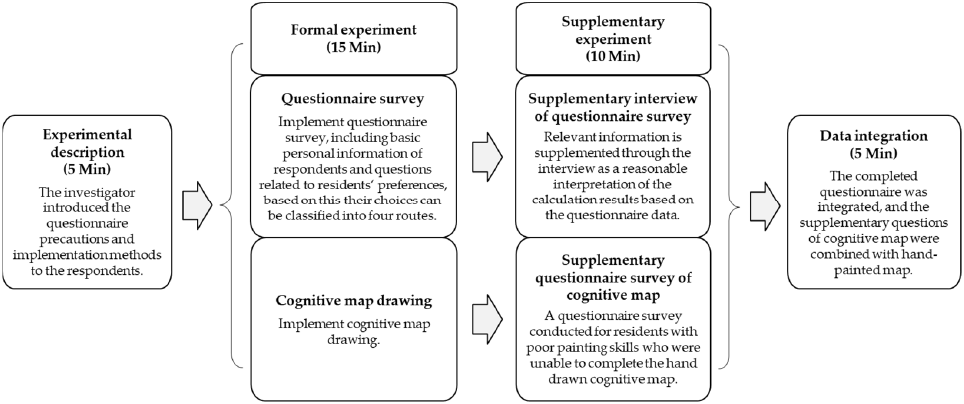
Figure 3. Timeline of the experimental session.